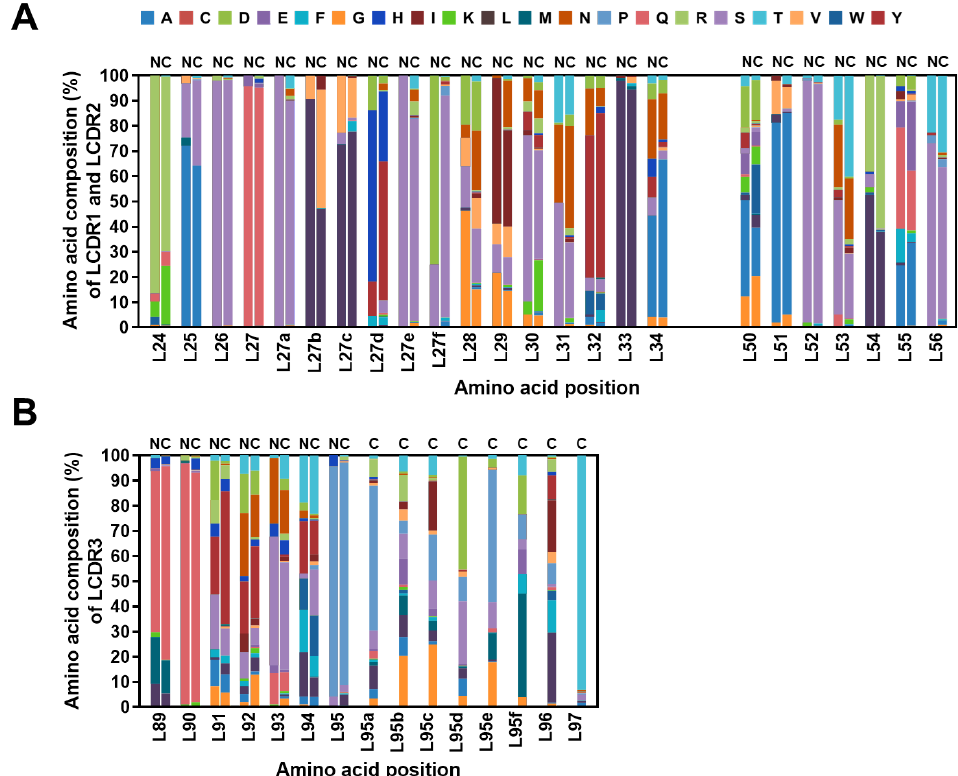
Figure 7. Diversity of the amino acid composition in the light chain complementarity-determining regions (LCDRs) of the constructed library. ( A ) The amino acid compositions at each position within LCDR1 and LCDR2 of natural human antibodies (N) were analyzed in comparison to those of the constructed library (C). The frequencies of amino acid occurrence in each position of LCDR1 and LCDR2 were compared with the reference sequences. ( B ) The amino acid incidence in LCDR3 was expressed as a percentage and represented in each stacked bar with designated colors. The x axis shows the amino acid position based on Kabat numbering.